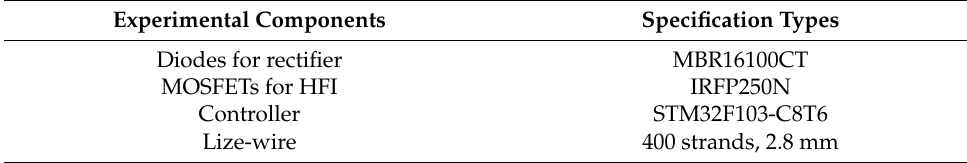
Figure 10. The experimental prototype of the CLC/N compensated WPT system. Table 4. The specification types of the experimental